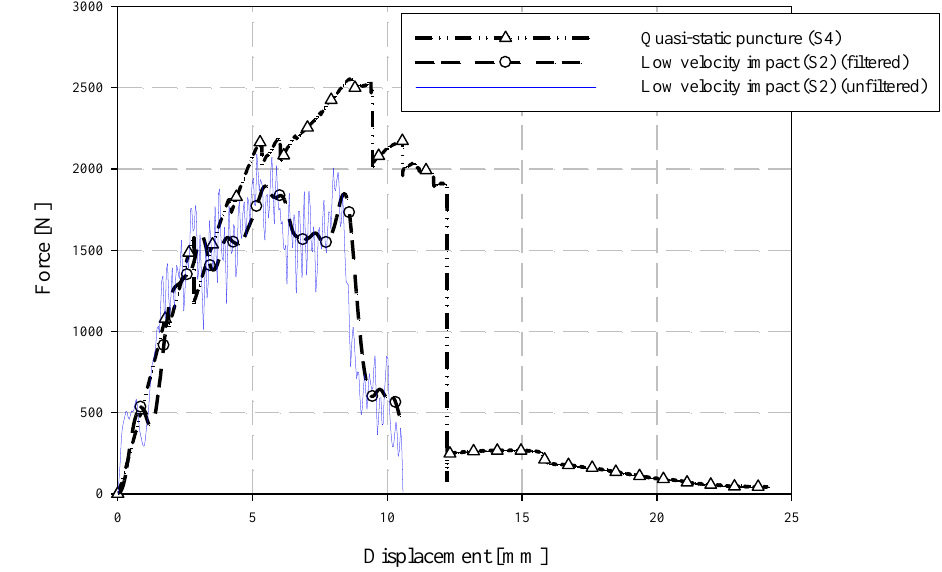
Figure 17. Comparison of quasi-static and low-velocity puncture force-deflection responses.